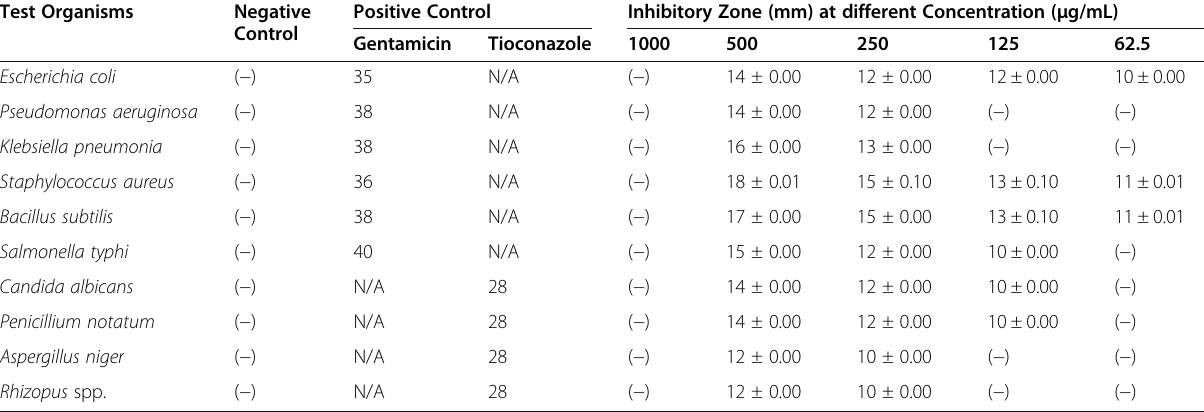
Table 3 Antimicrobial Activity of the Leaves Essential Oil of A. flagellaris showing zones of inhibition of the isolates at different concentrations compared to the Standard drugs (with reference to Well diameter of 100 mm) Test